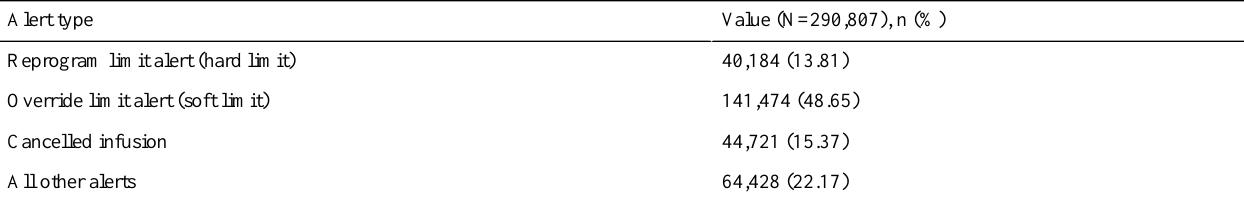
Table 3. All medication library alerts by type.